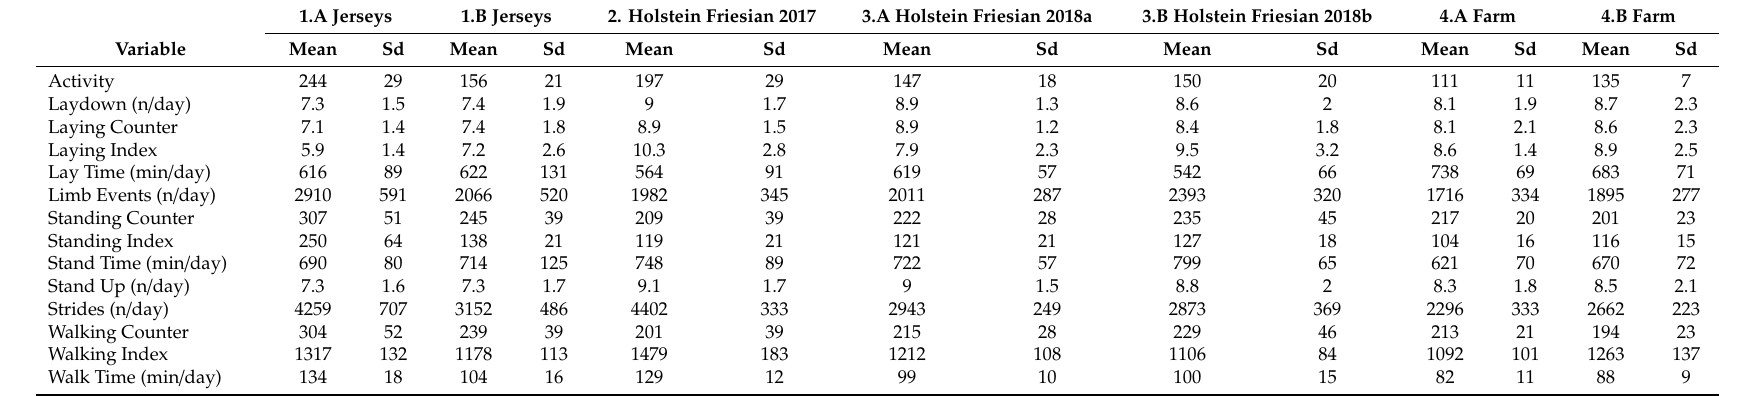
Table 3. 24-hour summary statistics for cows in each trial—mean and standard deviation